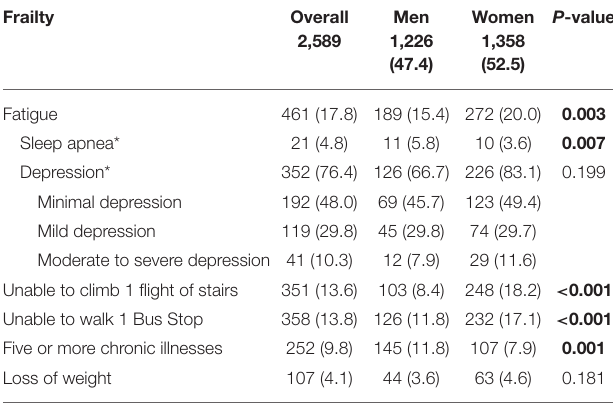
TABLE 2A | Frailty and